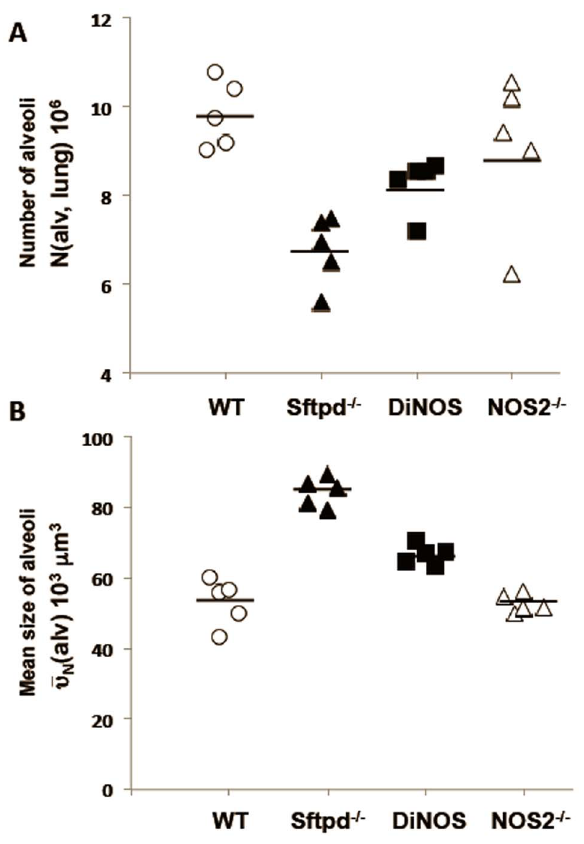
Figure 5. NOS2 ablation improves emphyatous phenotype resulting from the absence of SP-D. The number of alveoli per lung N(alv, lung) ( A ) is increased whereas the number-weighted mean volume of alveoli (cid:2) nn N (alv) ( B ) is decreased in the DiNOS mice compared to Sftpd 2 / 2 mice, indicating an attenuation of the pulmonary emphysema due to the additional ablation of the iNOS-gene in Sftpd deficient mice. Data shown are mean and individual data, n=5–6 animals per genotype. Statistically significant differences between groups are shown in Table 2.